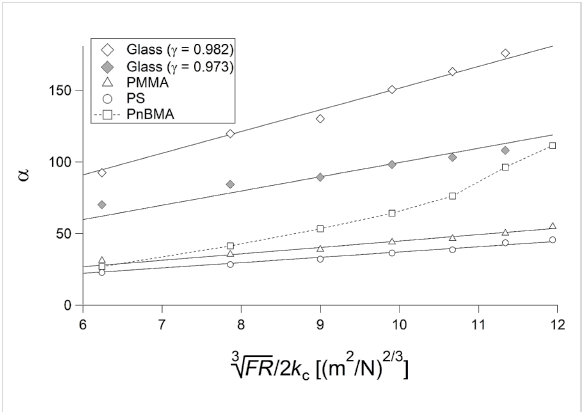
Figure 8: Normalized contact stiffness α on glass (white diamonds, calculated with γ = 0.982, and grey diamonds, calculated with γ = 0.973), bulk PMMA (triangles, γ = 0.973), and bulk PS (circles, γ = 0.973), fitted with a straight line through the origin (black lines). The normalized contact stiffness on PnBMA (squares, γ = 0.973) is shown, too.